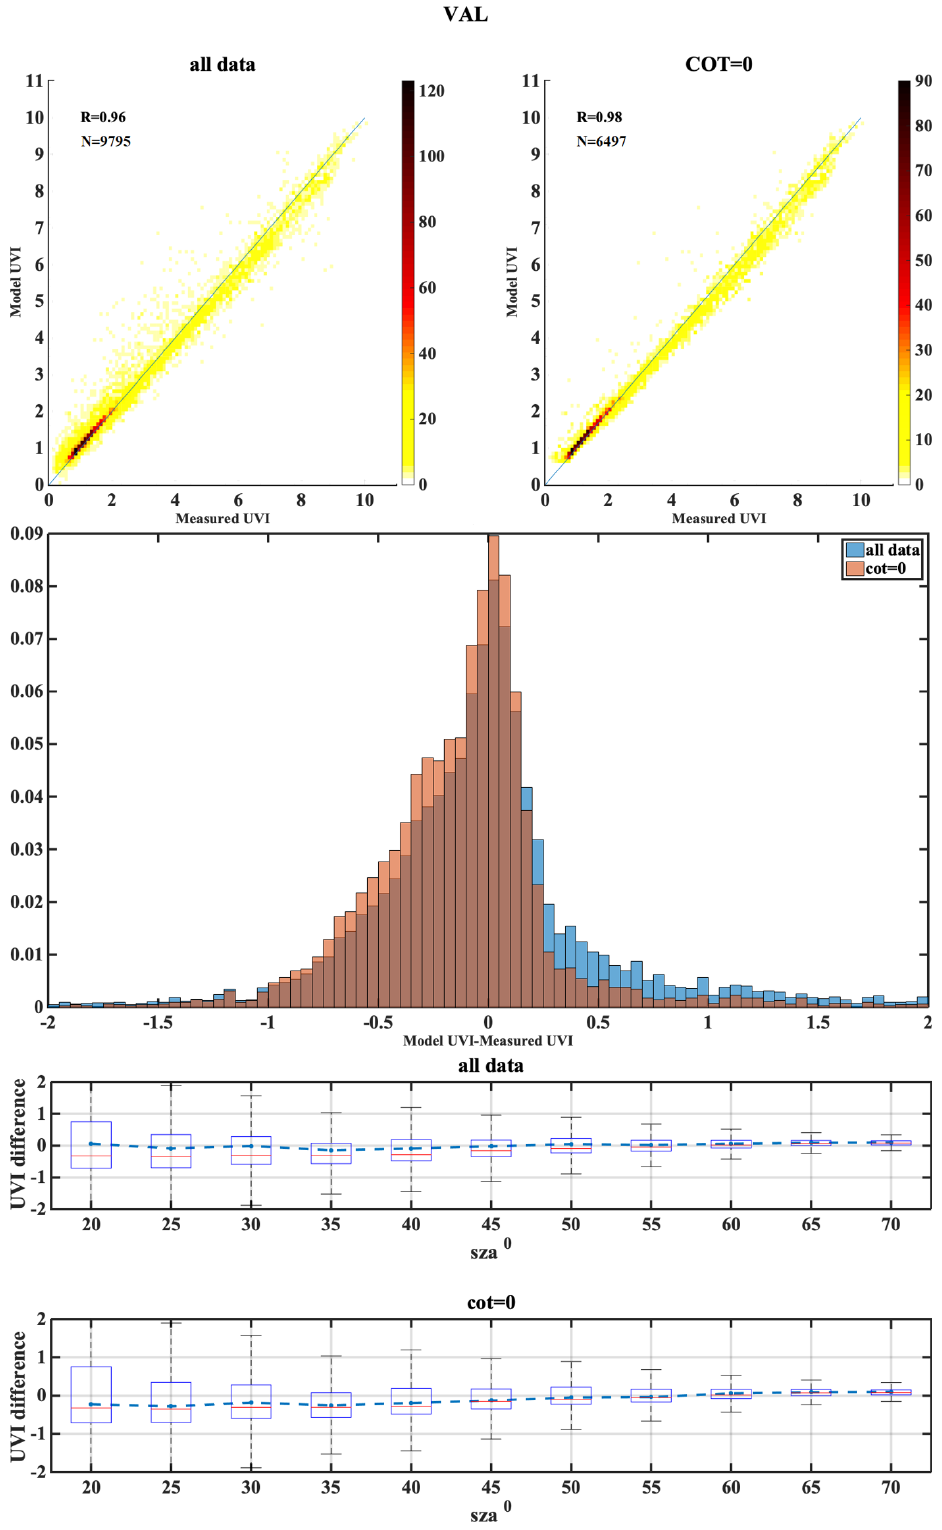
Figure A16. Same as above but for the VAL